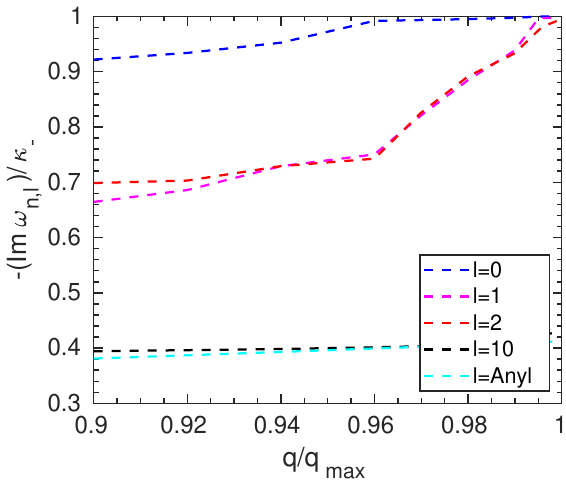
Table 6 . Numerical values of {− ( Im ω n,l ) /κ − } have been presented for the QNMs with different choices of ‘ . Here we have considered the value of the cosmological constant Λ = − 0 . 06 and mass M = 1 .